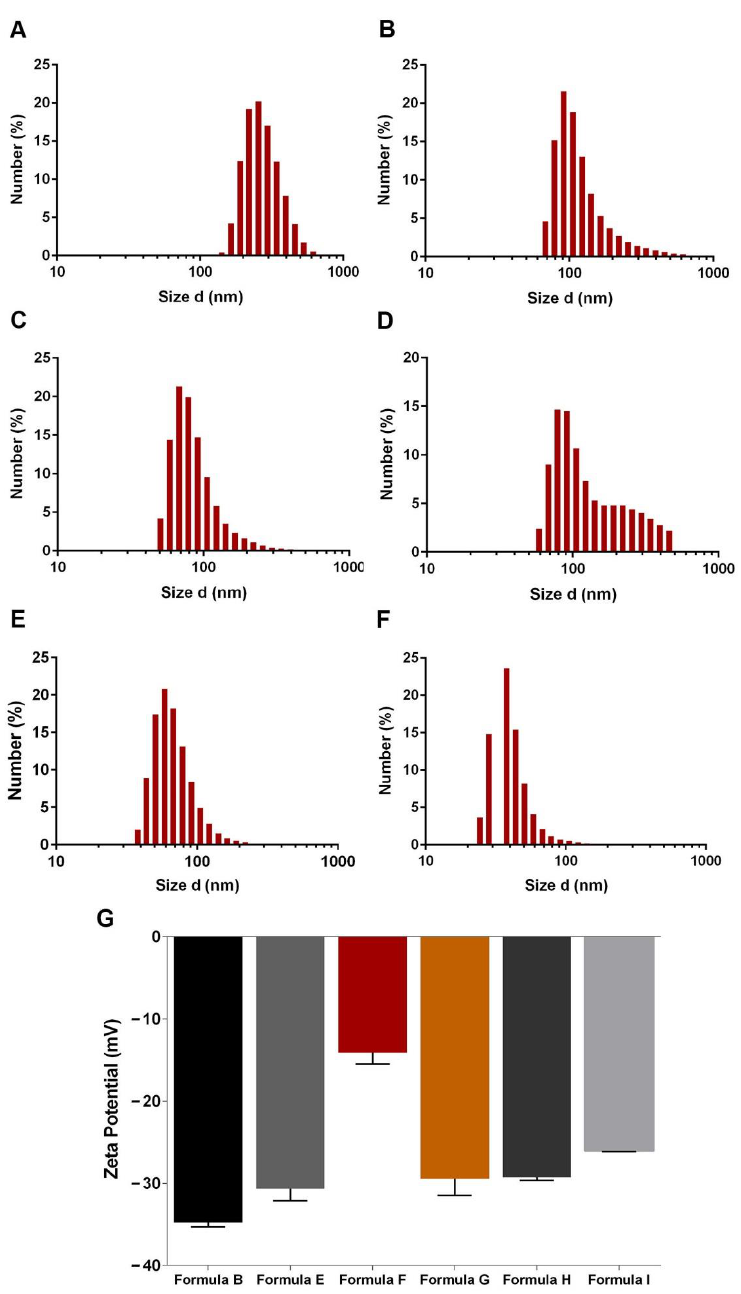
Figure 3. Physicochemical characterization of AuMSS nanoclusters formulations. ( A ) The size distribution of Formula B; ( B ) Formula E; ( C ) Formula F; ( D ) Formula G; ( E ) Formula H and ( F ) Formula I, n = 300. ( G ) Analysis of the AuMSS nanoclusters’ surface charge, n = 3.